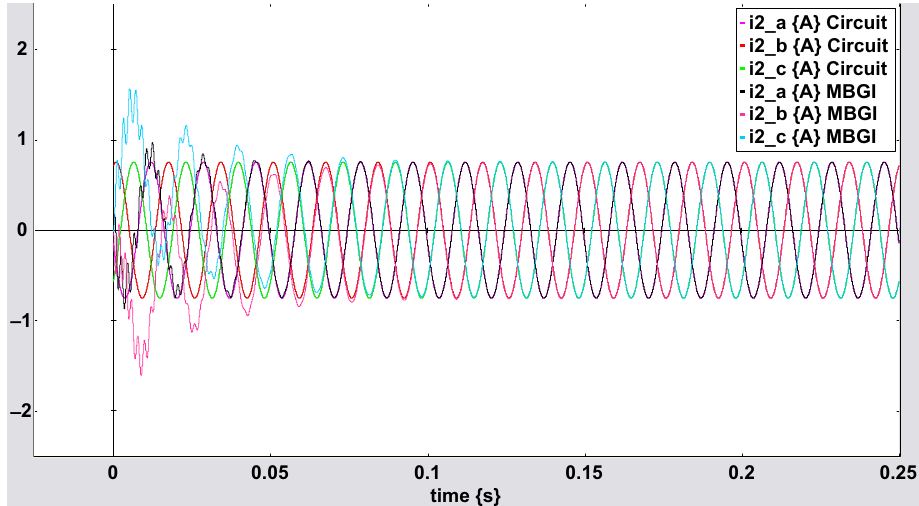
Figure A5. Three-phase current for i 2 using the equivalent reduced circuit and